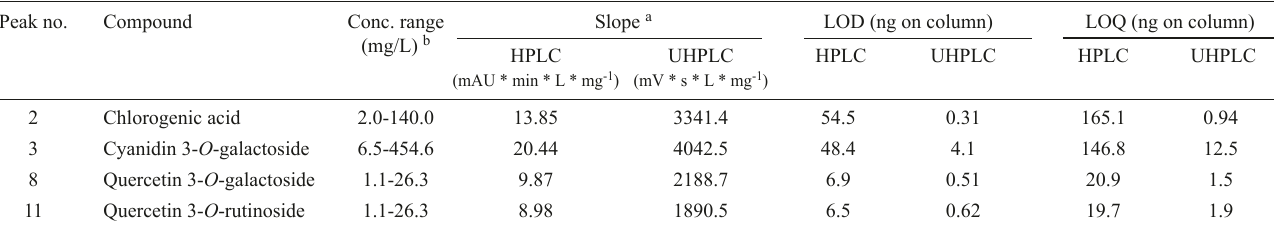
Tab. 1: Linear concentration ranges, detection parameters, slope of calibration curves, limit of detection (LOD), and limit of quantitation (LOQ) of reference standards (chlorogenic acid, cyanidin 3- O -galactoside, quercetin 3- O -galactoside, and quercetin 3- O -rutinoside) used for validation of the HPLC- and UHPLC-based methods.